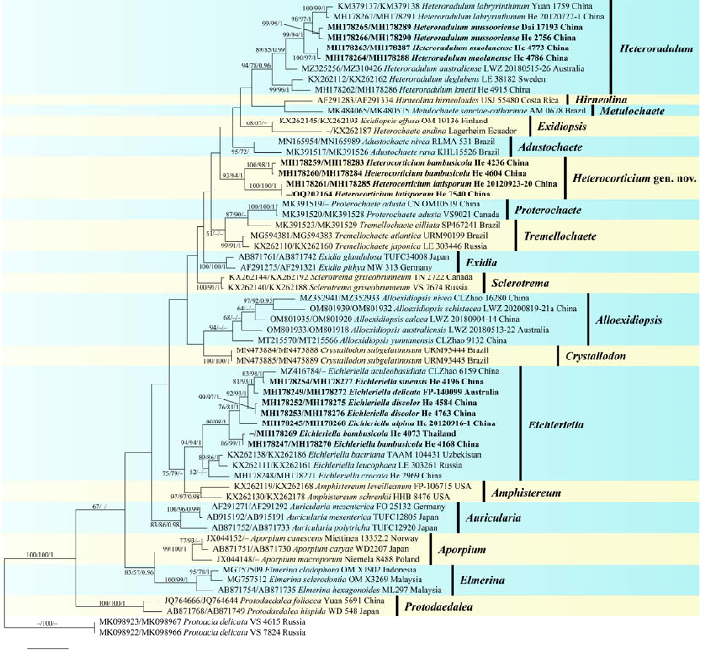
Figure 2. Phylogenetic tree of MP analysis from the concatenated ITS-28S sequences of Auriculari- aceae taxa. Branches are labelled with parsimony bootstrap values ( ≥ 50%, first), likelihood bootstrap values ( ≥ 50%, second), and Bayesian posterior probabilities ( ≥ 0.95, third). New species and new combinations are set in bold.